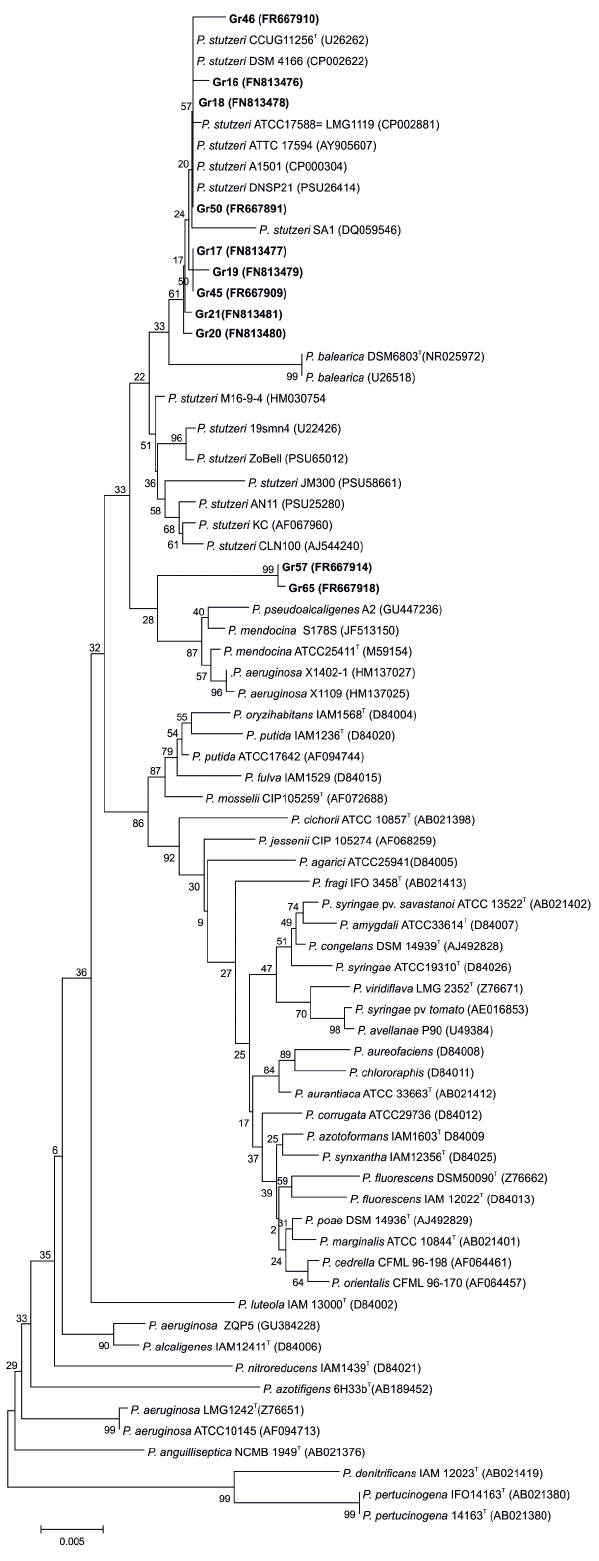
Figure 3. 16S rRNA phylogenetic tree. Neighbor-Joining phyloge- netic tree of 16S rRNA gene constructed using the partial nucleotide sequence from the 11 P. stutzeri isolates and related sequences obtained from NCBI [40]. Numbers shown at nodes indicate bootstrap values (percentage of 1000 replicates). The trees were constructed